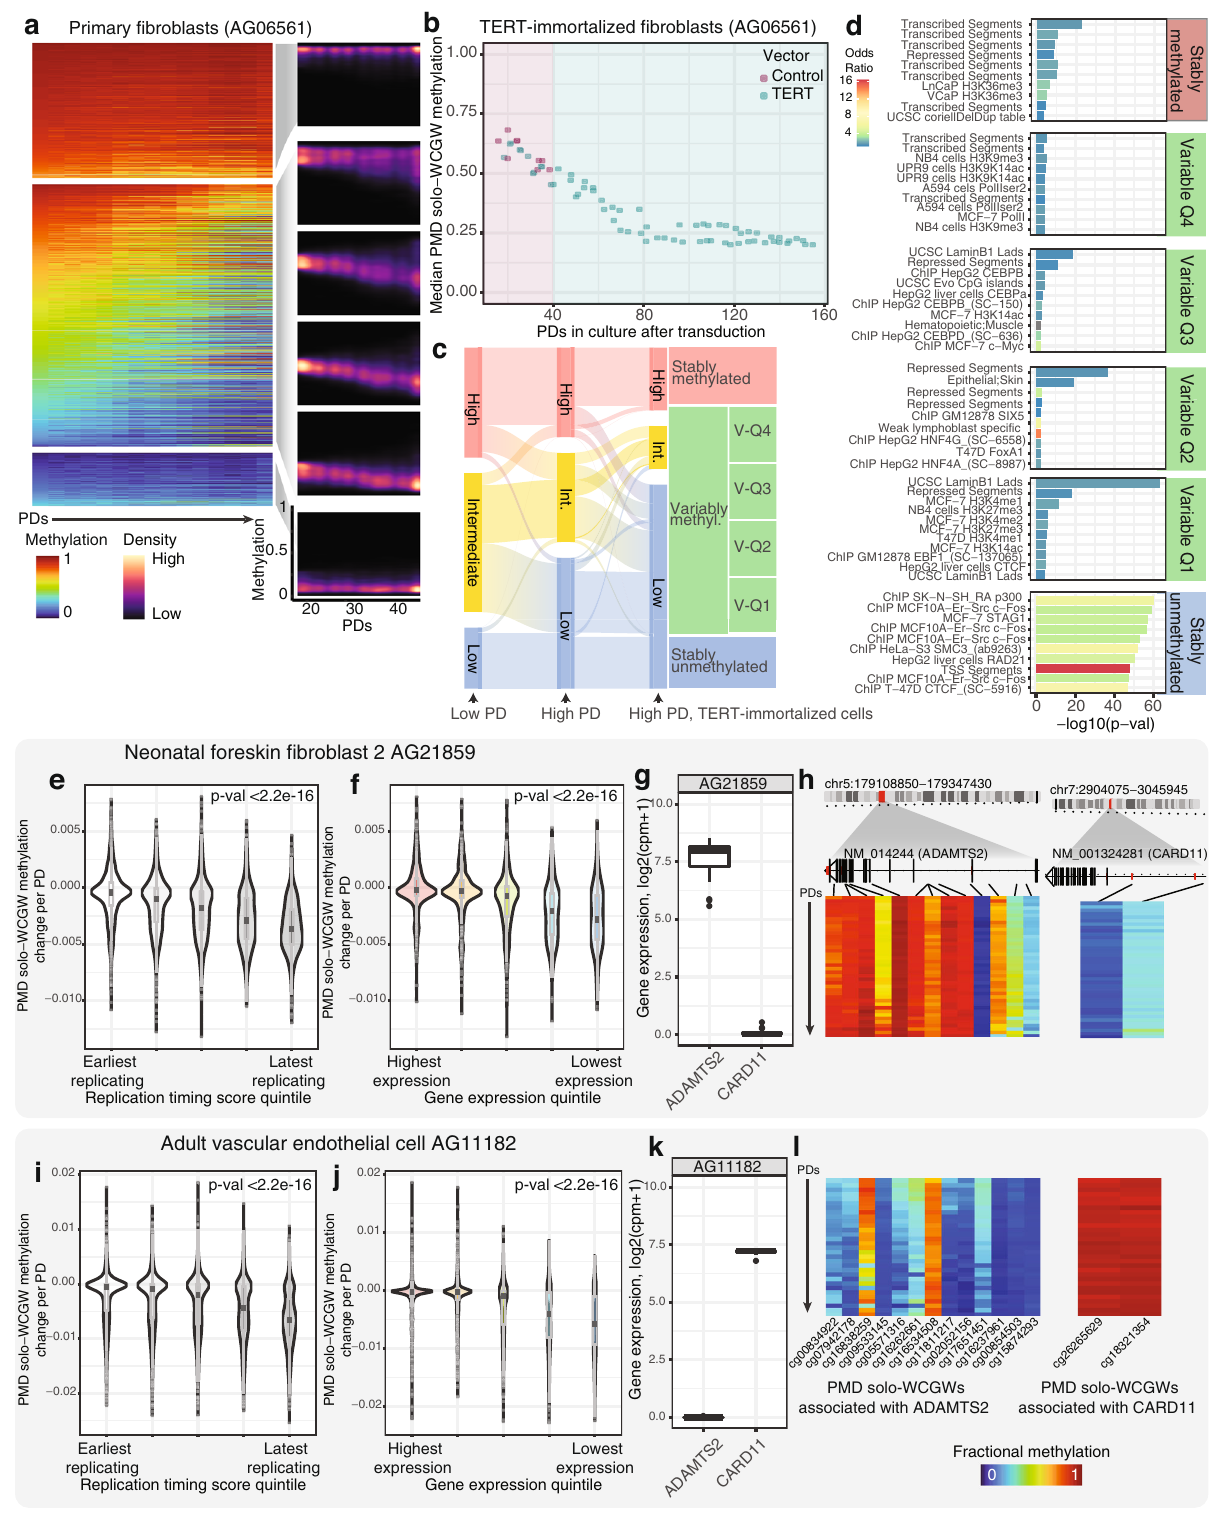
differential expression between fi broblast AG21859 and endothelial cell AG11182 displayed alternate methylation at associated PMD solo- WCGWs (Fig. 2g, h, k, l). Genes with similar expression levels displayed similar methylation(Supplementary Fig.7).Wealsoexaminedwhether the presence of H3K36me3 in fl uenced the rate of methylation